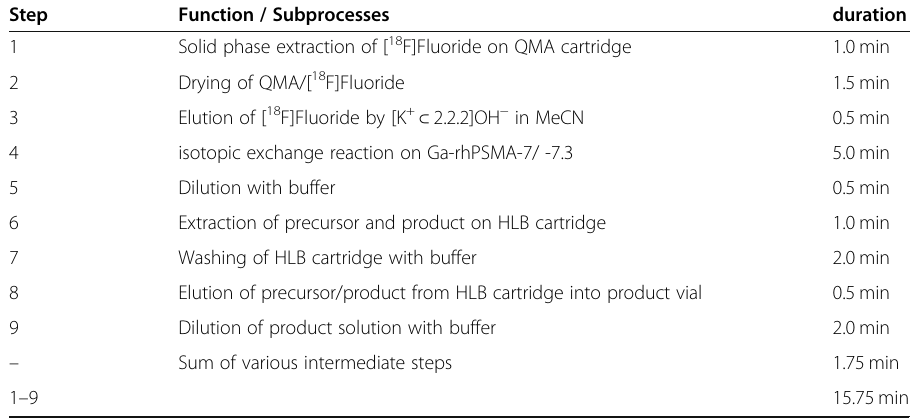
Table 1 Description of the 9-step fully automated GMP production of [ 18 F]Ga-rhPSMA-7/